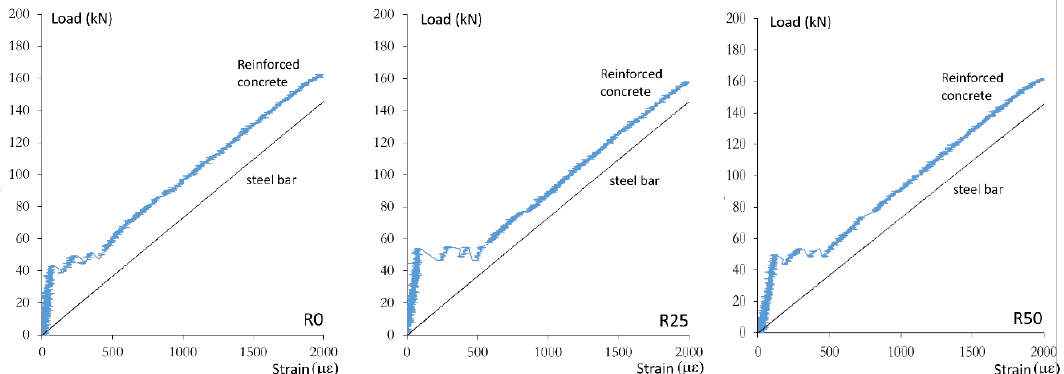
Figure 7. Experimental results for tension stiffening elements without recycled aggregate (R0) and with substitution of 25% (R25) and 50% (R50) of natural aggregate for recycled aggregate.